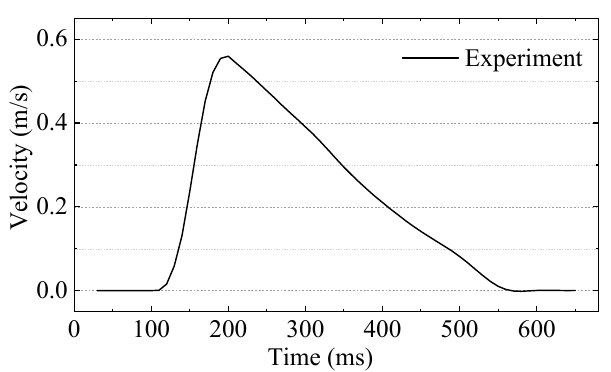
Figure 24. Velocity of the mover versus time.